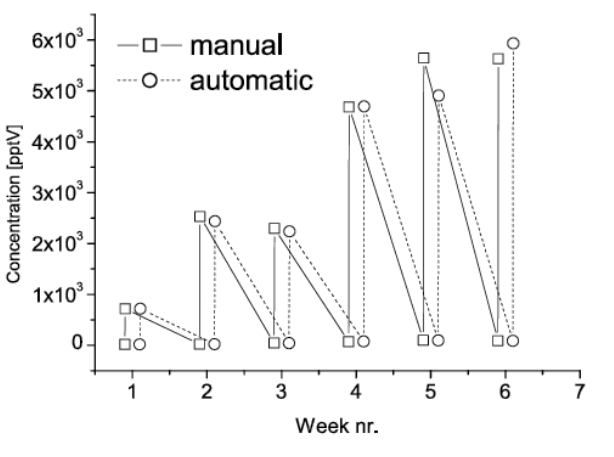
Figure 5. Time course of the concentration of 2-carene after manual and automatic processing of gas chromatography–mass spectrometry data. The data points have been offset to allow